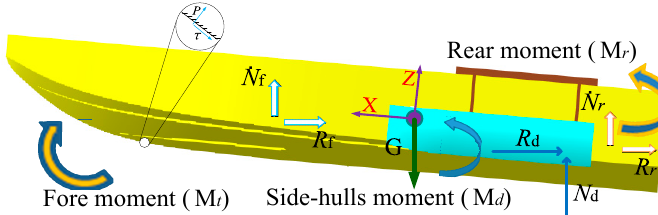
Figure 17. Comparisons of the hull bottom pressure in the MFS and TFS when L cg /L m = 0.38.